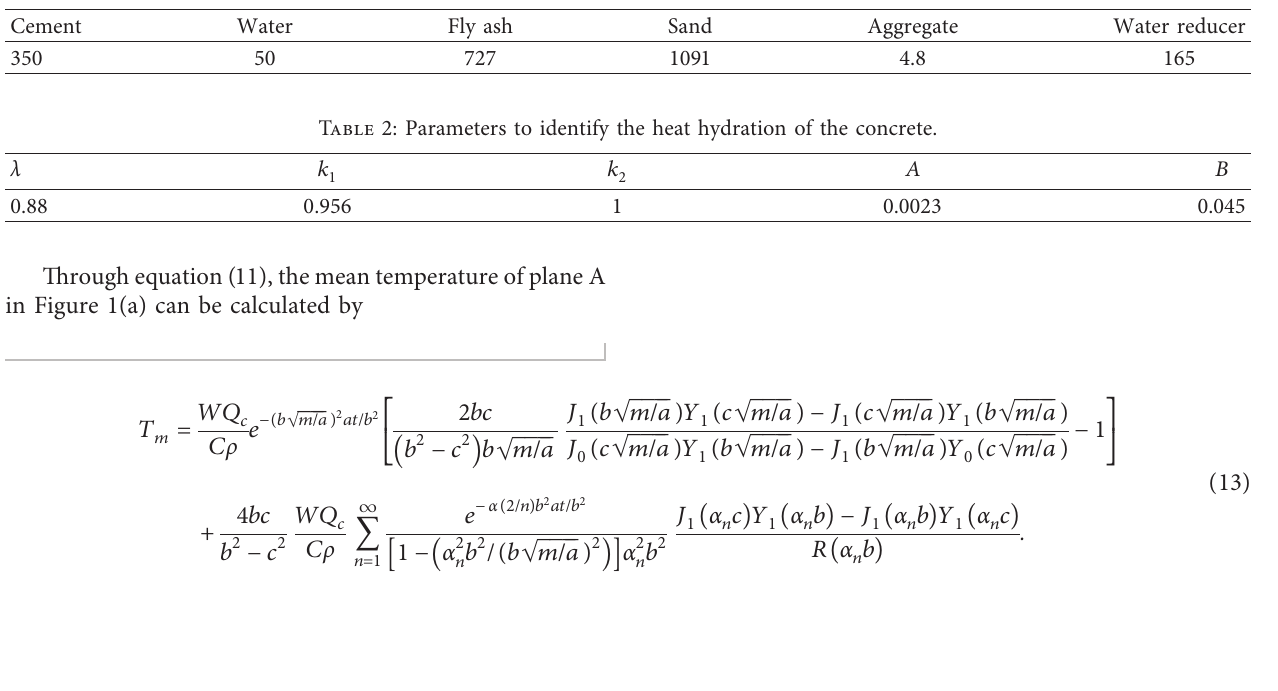
Figure 2: The hydration heat of cement in different ages. Table 1: The proportion of the concrete (kg/m 3 ).